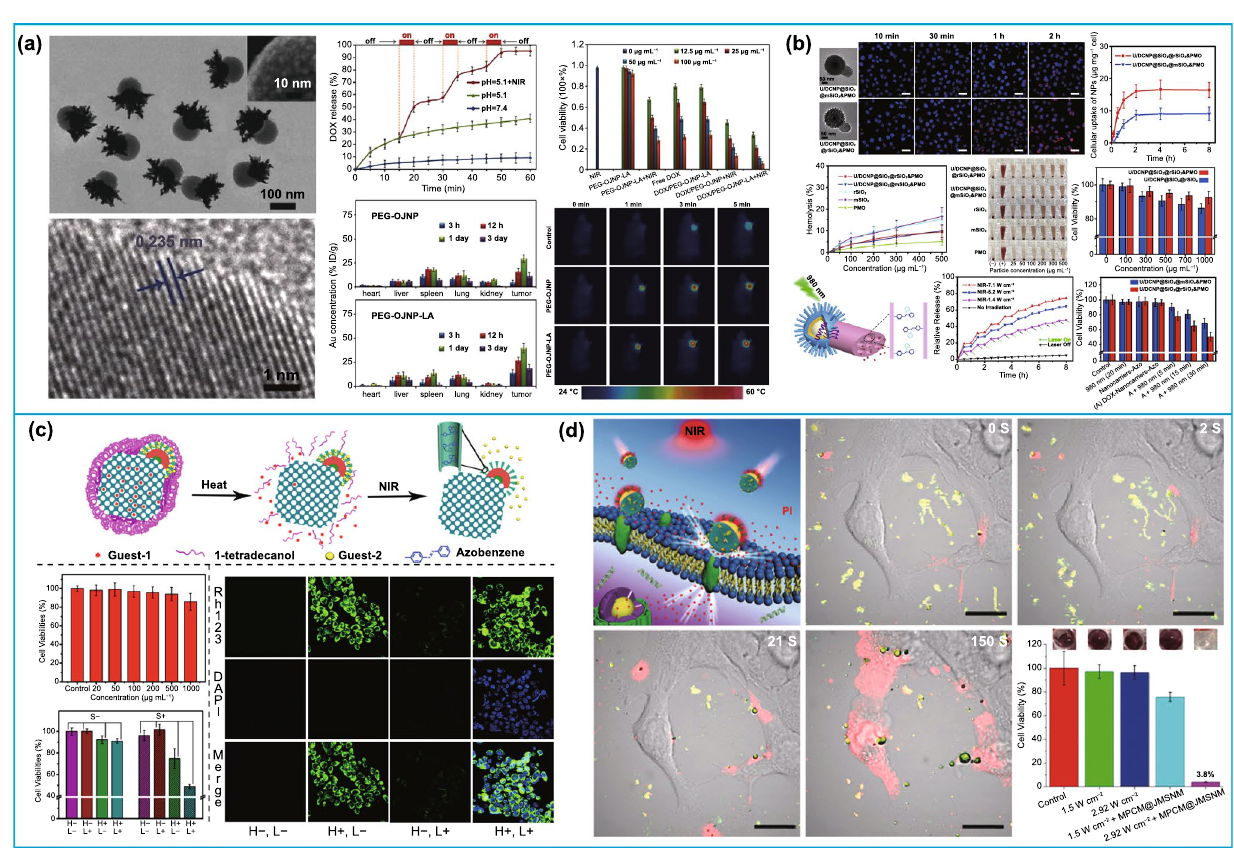
Fig. 13 Application of asymmetric structure in biomedicine. a PEG-Au-PAA/mSiO 2 -LA Janus NPs for synergistic actively targeted and chemo- photothermal therapy. Reproduced with permission from Ref. [47]. Copyright 2016, Wiley-VCH. b Engine-trailer-structured nanotrucks for enhanced drug delivery. Reproduced with permission from Ref. [217]. Copyright 2020, Elsevier B.V. c Dual-compartment asymmetric silica nanocomposites for dual-drug delivery. Reproduced with permission from Ref. [122]. Copyright 2014, American Chemical Society. d MSNs- based nanomotor for thermomechanically percolating cell. Reproduced with permission from Ref. [148]. Copyright 2018,